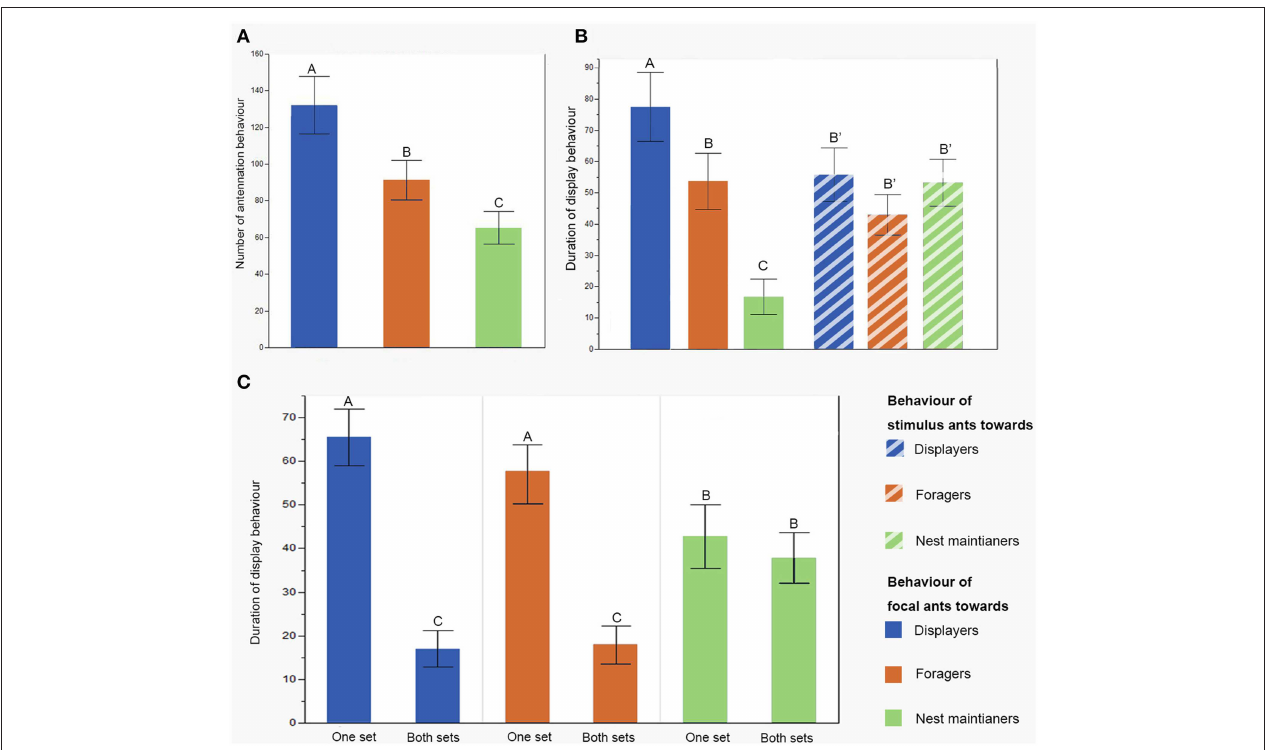
FIGURE 2 | Antennation and aggression behavior of the focal ants toward ants of the three task groups. (A) The variation in antennation frequency of the focal ants toward the three task groups; (B) the duration of display behavior of the focal ants toward the three stimulus task groups, and the stimulus ants toward the focal ants. (C) Focal ants cannot discriminate tasks when the CHCs on the legs were removed in displayers and foragers, as the level of aggression was significantly reduced (tasks: F 2,242 = 0.416, p = 0.6605; leg wash: F 1,242 = 53.56, p < 0.0001; task × leg wash: F 2,242 = 9.506, p = 0.0001; error bars indicate SEM, different letters signify significantly different